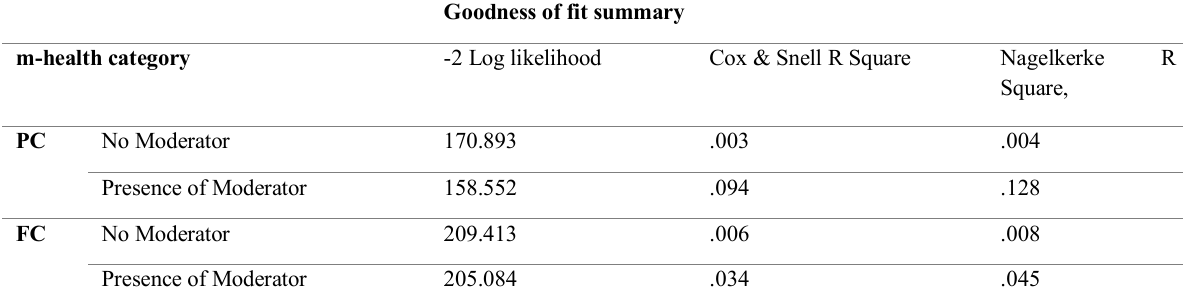
Table 6: Model TLS Summary for Goodness of Fit Test Transformational Leadership Style